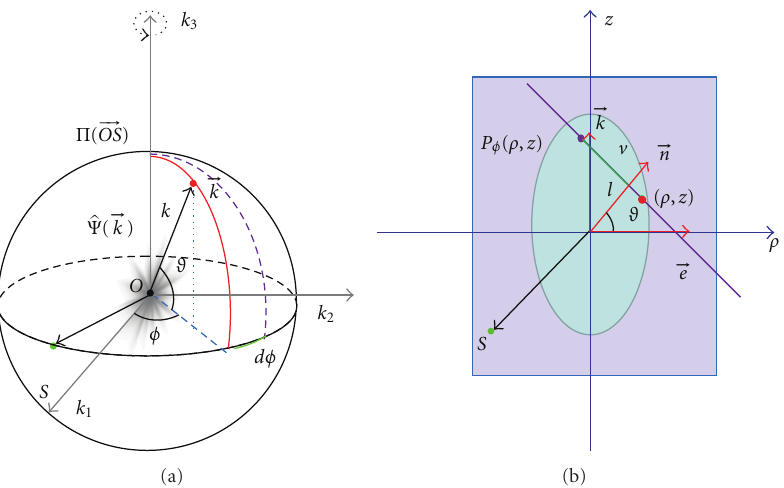
Figure 2: The sphere coordinate system and the detector plane. (a) The sphere coordinate system in the Fourier domain, and (b) the relationship between projections and the Radon